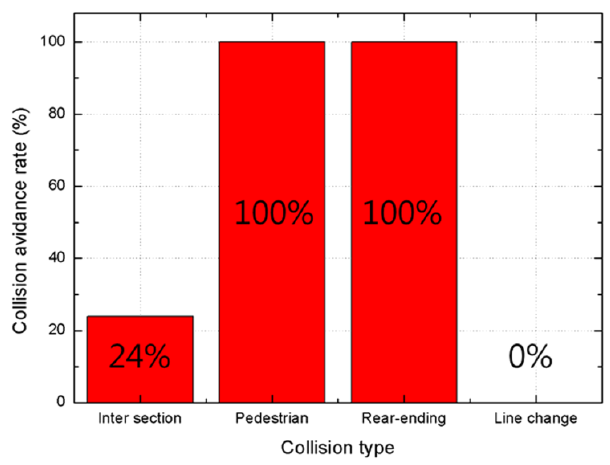
Figure 17. Collision avoidance rate in a real case. Table 6. Additional simulation results for